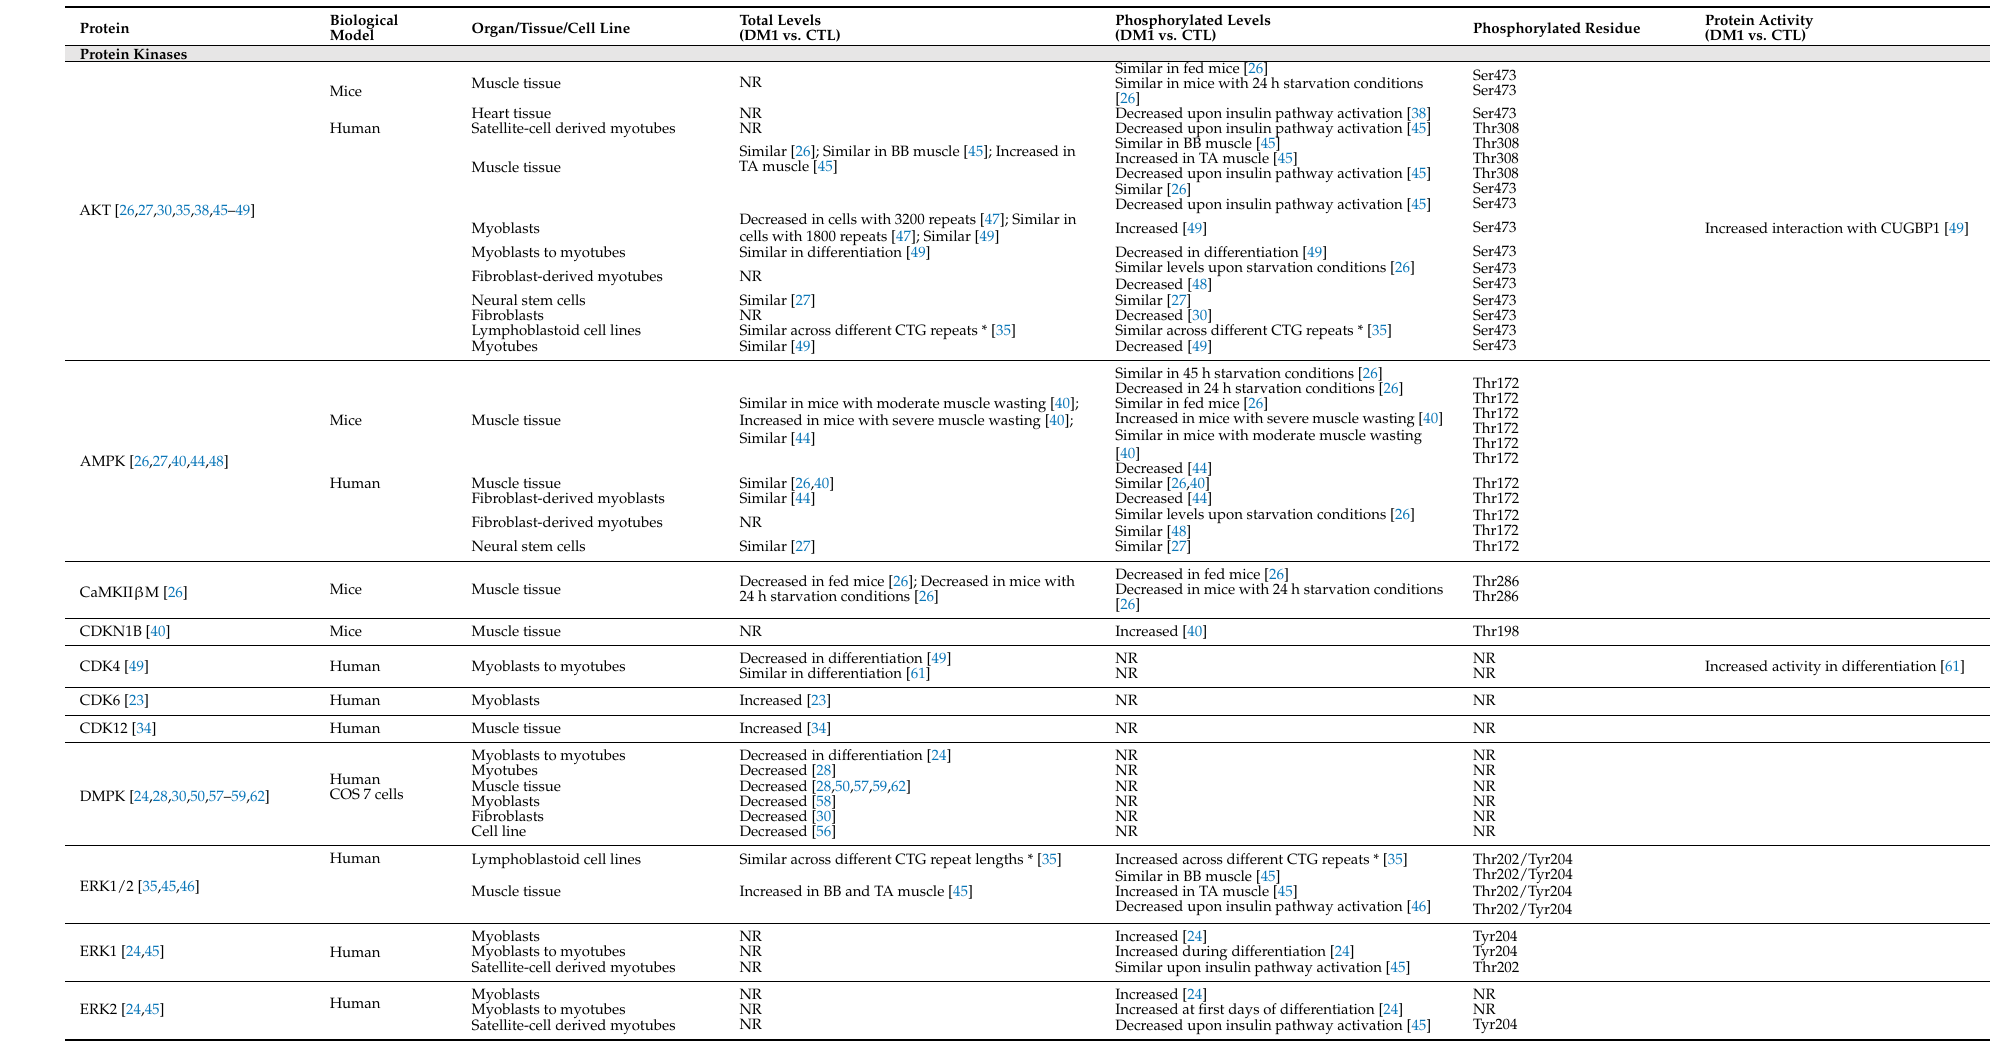
Table 1. Summary of the main findings of the different proteins’ total and phosphorylation levels in